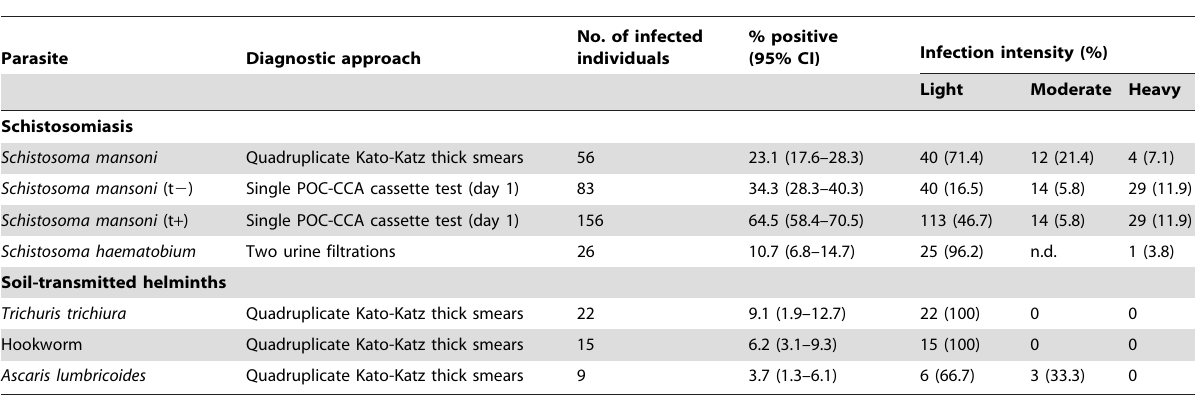
Table 2. Baseline prevalence of helminths according to diagnostic approach ( n